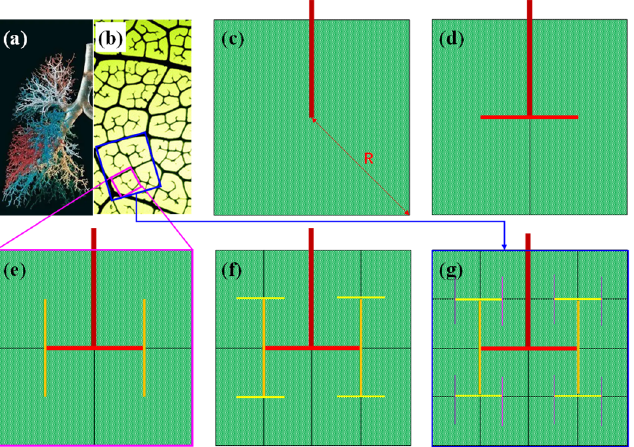
Figure 4. Photograph of ( a ) lung trachea and ( b ) leaf microveins. ( c – g ) the formation diagram of typical micro leaf veins/bronchus based on cell region partitioning. Note that the side length of the largest square is doubled in each step from ( c ) to ( g ).